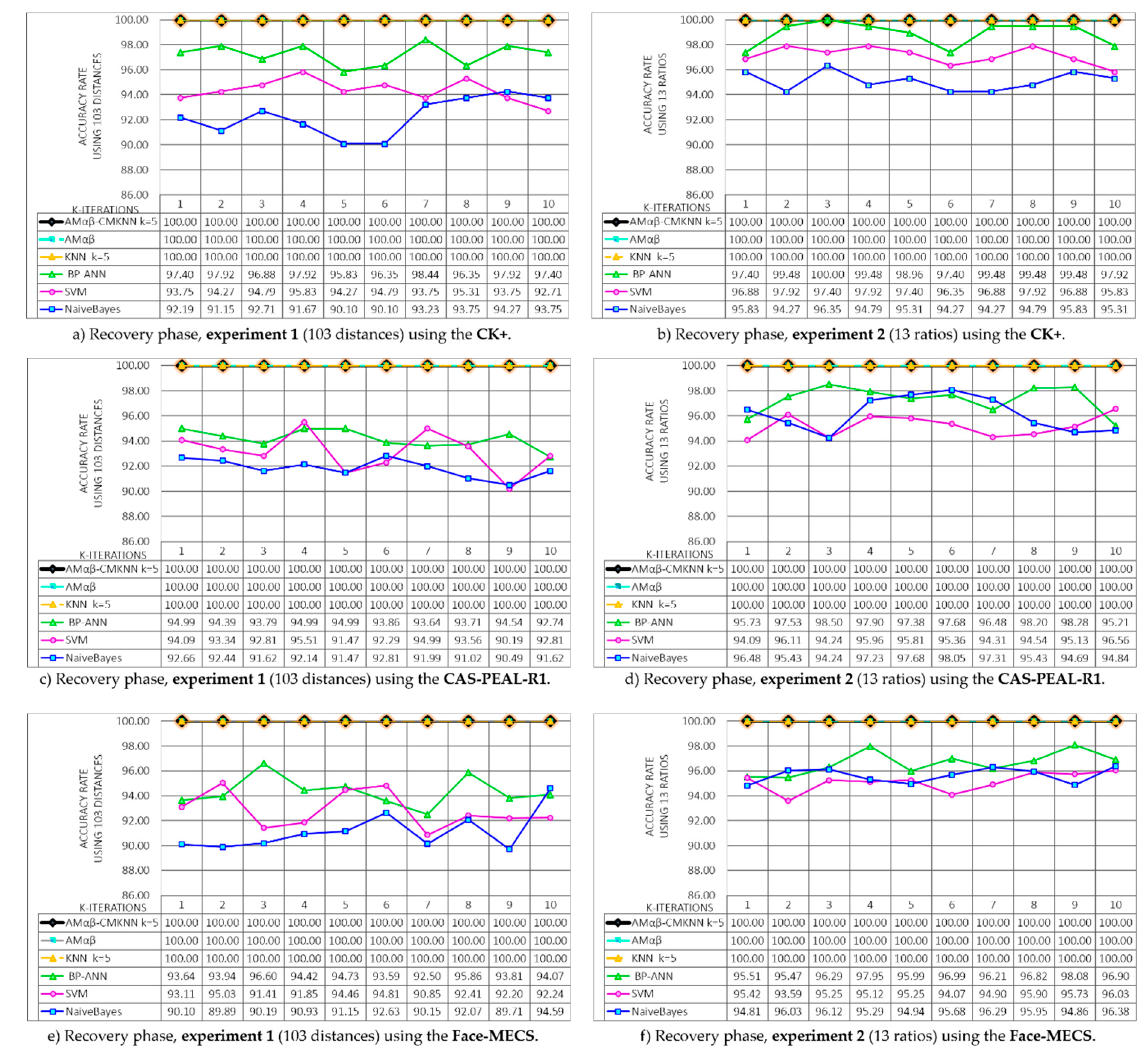
Figure 13. Results of the 10 test rounds of the k-fold-cross validation method applied during the recovery phase of Experiments 1 and 2 using the CK+, CAS-PEAL-R1 and Face-MECS recovery phase of Experiments 1 and 2 using the CK+, CAS-PEAL-R1 and Face-MECS databases.